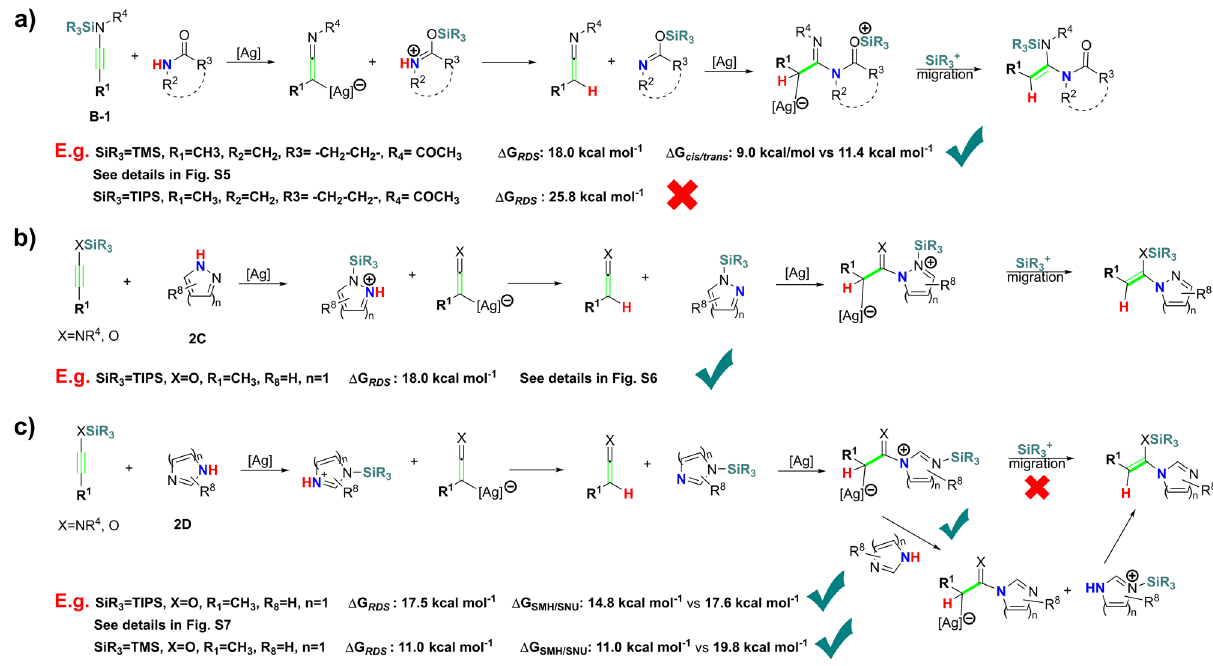
Fig. 7 Possible substrates scope of alkynes and p – π conjugation system of SMH pathway. a N -silyl protected ynamide or ynamine as substrates. b Cyclic 1,2- N- substituted p – π conjugation systems as substrates. c Cyclic 1,3- N- substituted p – π conjugation systems as